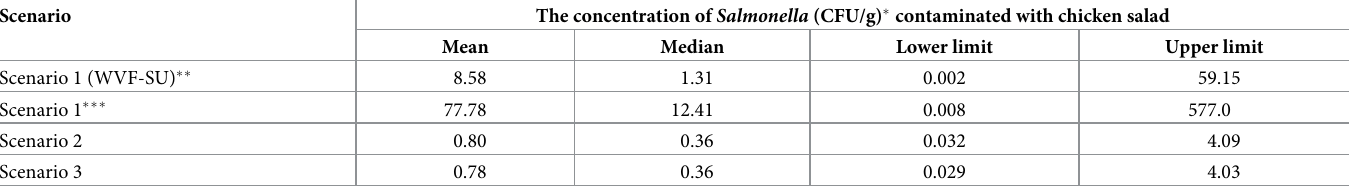
Table 5. Salmonella (CFU/g) concentration was simulated in each scenario in the ready-to-eat chicken salad, based on the experiment values with 5000 iterations.